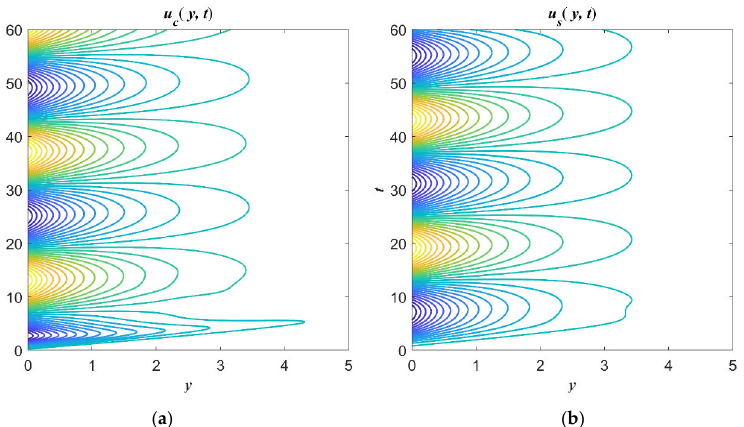
Figure 10. Contours profiles of the dimensionless starting solutions u c ( y , t ) and. u s ( y , t ) (numerical solutions) for α = 0.8, β = 0.7, γ = 0.6, ω = π /12, M = 0.6, and K = 0.4. The trajectory paths with the minimum value are denoted in blue colors while those with the maximum